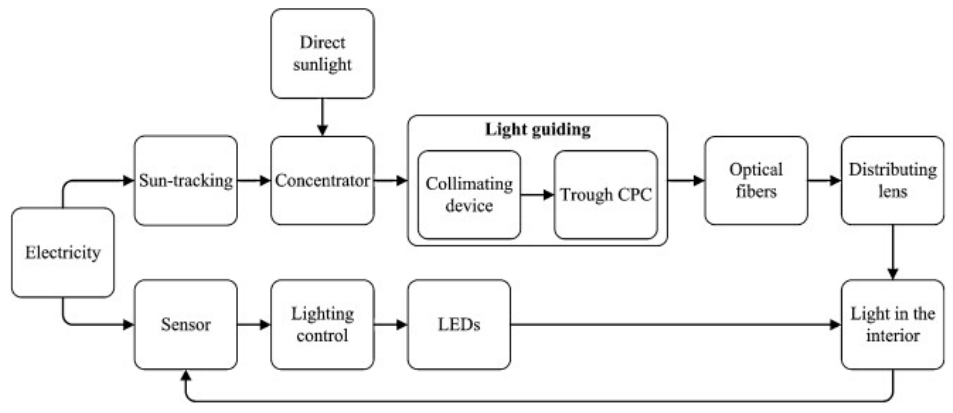
Figure 4. Flow chart of the proposed hybrid daylighting system [47].